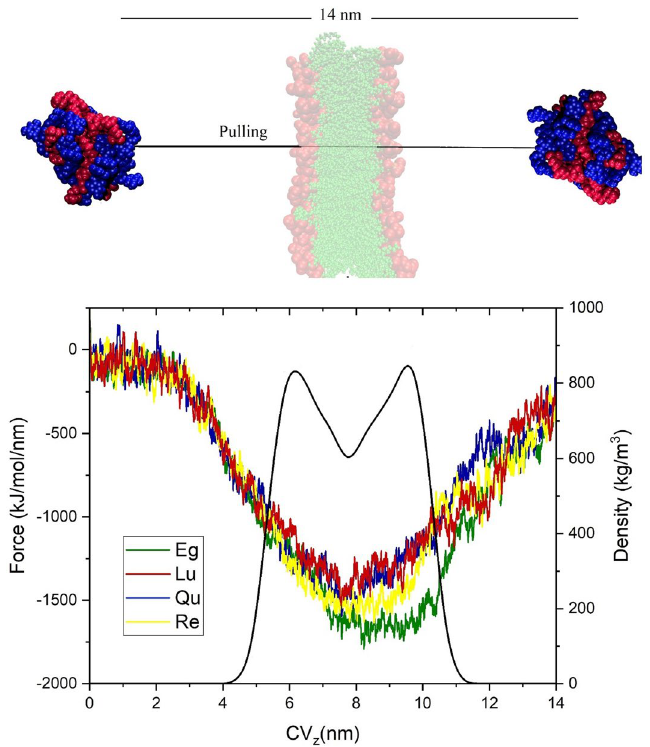
Figure 18. Illustration of the pulling simulation of phytosome through the cell membrane and the bottom) Force vs. collective variable (CV z , the COM position of the phytosome in the z-direction) during SMD. The black curve in the bottom panel represents the density profile of the